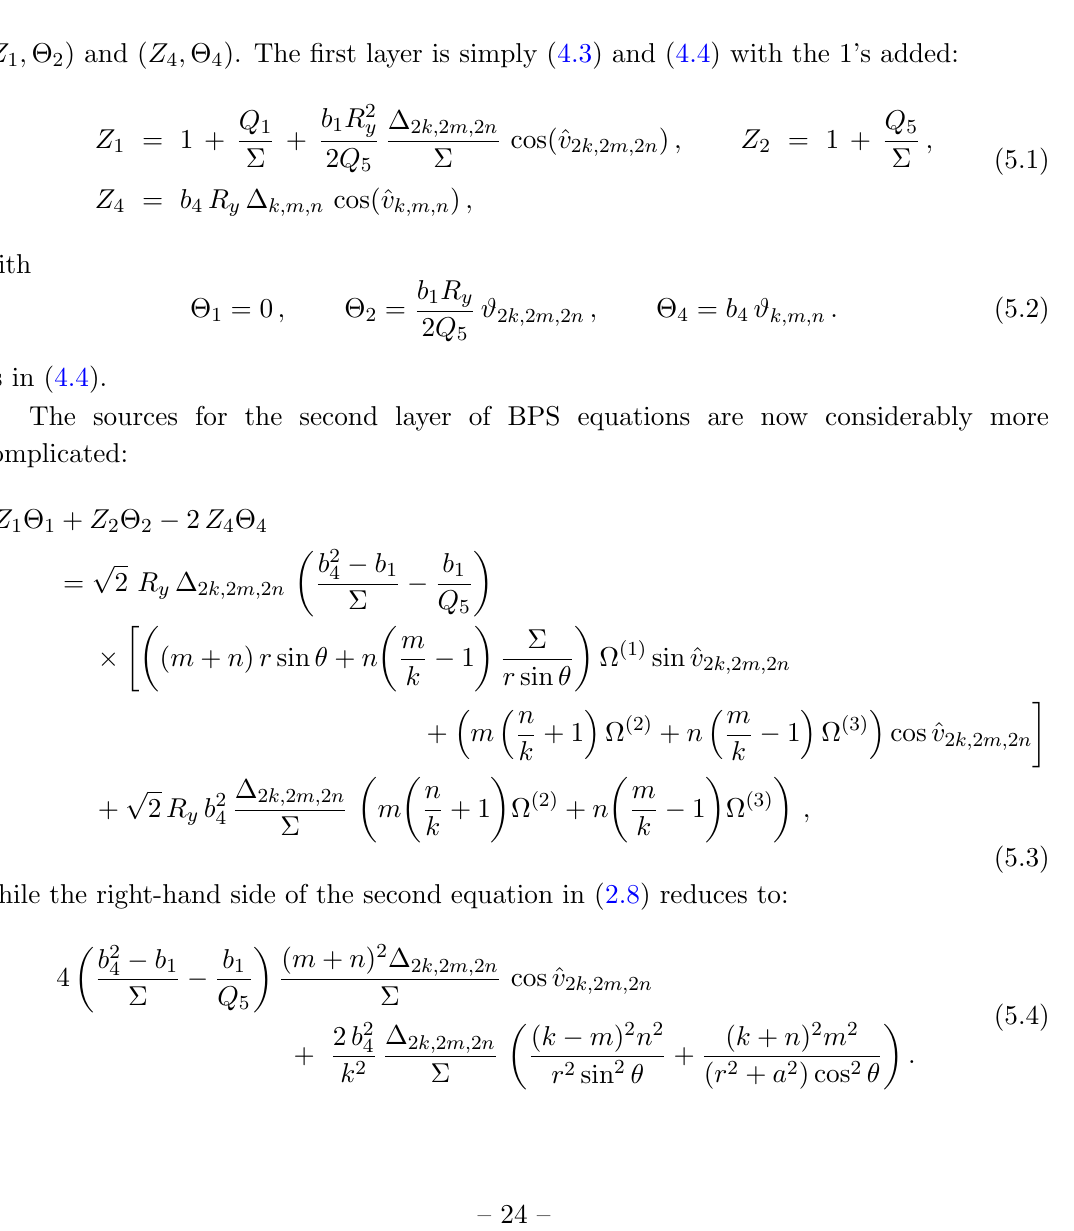
Figure 2 . Left plot: log-log plot of the proper length of a curve around the y circle as described in the text (vertical axis), as a function of r in units of a (horizontal axis), where we set (cid:18) = (cid:25)= 4. Right: linear plot detailing the behaviour in the cap region. Parameters chosen: k = 1, m = 0, n = f 4 ; 9 ; 16 g (from bottom to top); a = 1,